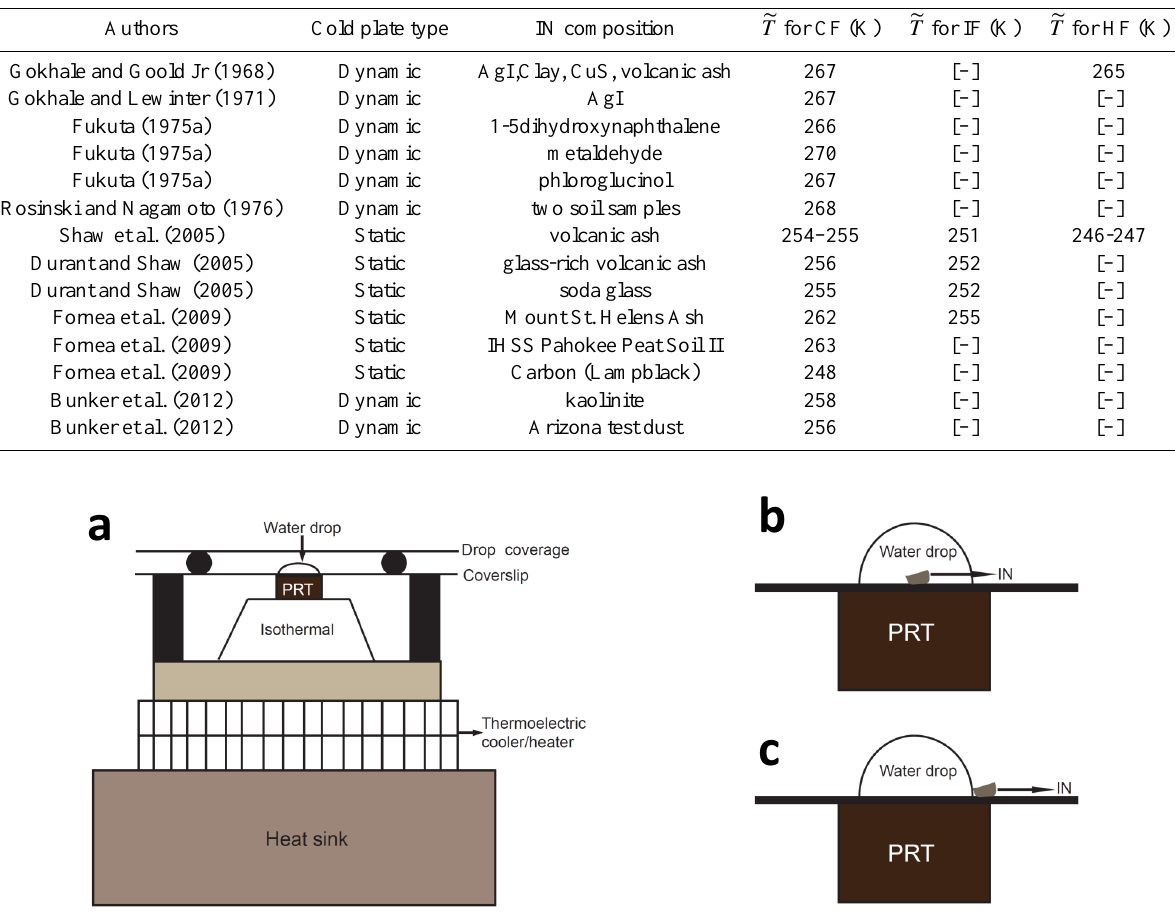
Fig. 5. (a) Schematic with the cold plate experimental setup (left), (b) of the IN for an immersion freezing (top right) and (c) for a contact freezing experiment (bottom right) (Shaw et al.,